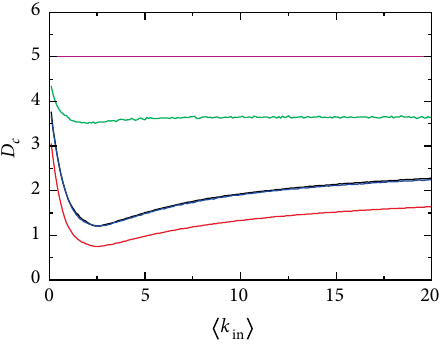
Figure 8: 𝐷 as the function of average degree of internal links ⟨𝑘 in ⟩ 𝑐 when the initial shock is in the start-up layer, for different weight distributions: uniform (black), exponential (red), truncated normal with 𝜎 = 0 (magenta), 𝜎 = 1 (green), and 𝜎 = 3 (blue).